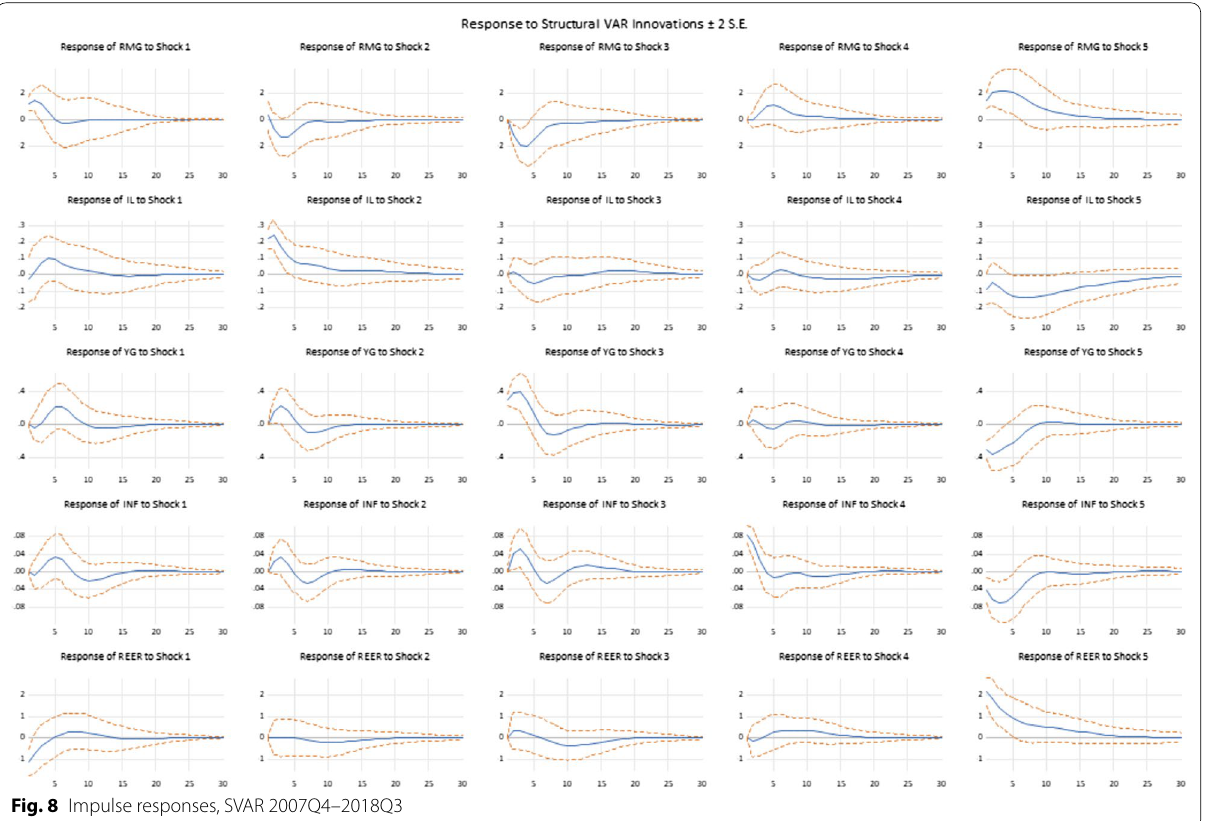
Fig. 8 Impulse responses, SVAR